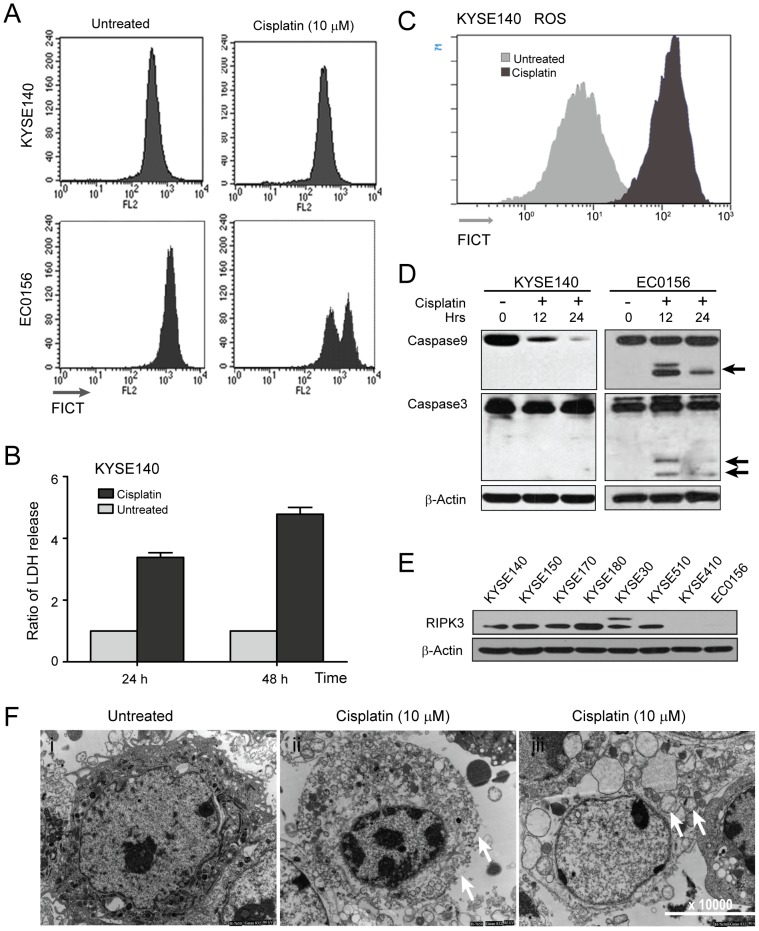
Cisplatin triggers programmed necrosis in KYSE140 cells.(A) Mitochondrial membrane potentials of KYSE140 and EC0156 cells were determined using Mito Tracker Red CMXRos staining and analyzed by flow cytometry after cisplatin treatment for 24 h. (B) Cellular necrosis was measured as LDH release after cisplatin treatment for 24 h and 48 h. (C) KYSE140 cells were treated as indicated for 12 h. The cells were stained with H2DCF-DA for 20 min, and then ROS levels were measured using flow cytometry. All experiments were performed at least three times. (D) KYSE140 and EC0156 were treated with 10 µM cisplatin for 12 or 24 h. Caspase activation was assessed by western blotting. Arrowheads indicate caspase cleavage fragments. (E) Total cellular protein extracts from each of the eight esophageal cancer cell lines were subjected to western blot analysis for RIPK3. β-Actin as a loading control. (F) Transmission electron microscopy of the KYSE140 cells after cisplatin treatment. Membrane integrity was noted in the control cells, and the collapse of the membrane and the swelling of the cellular organelles were noted in the cells treated with cisplatin.